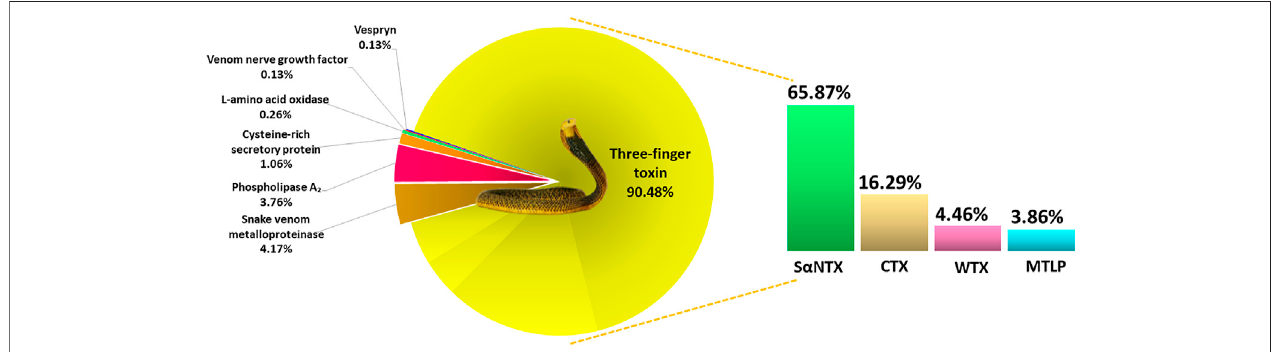
FIGURE4| Venomproteomeof Najasamarensis classi fi edaccordingtothetoxinproteinfamilies,withrelativeabundances(%)basedonHPLCpro fi leandrelative spectral intensity from mass spectrometry analysis (as described in the method section). Abbreviations: CTX, cytotoxin; MTLP, muscarinic toxin-like protein; S α NTX, short-chain alpha-neurotoxin; WTX, weak